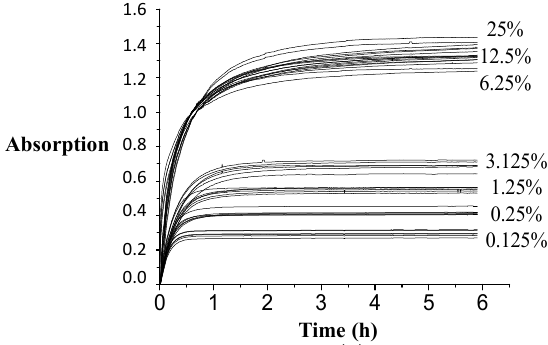
Figure 9. Plots of the experimental kinetics data for different concentrations of ammonia solution at 25 °C.